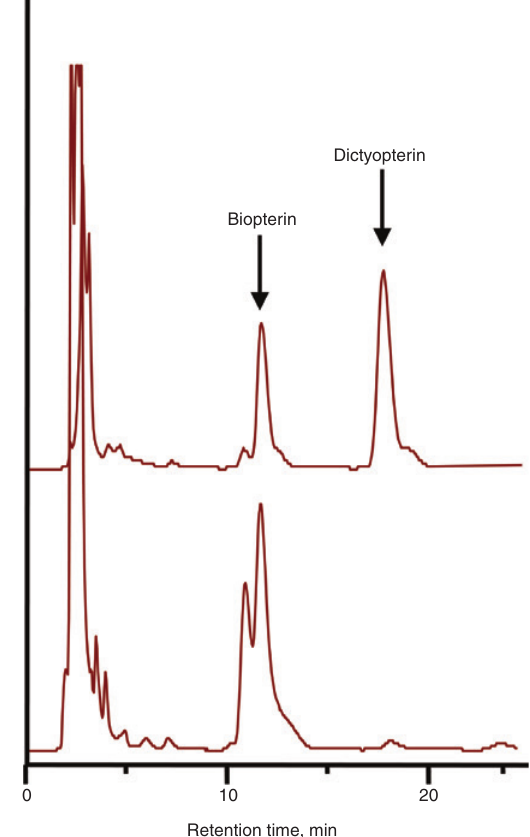
Figure 1: HPLC analysis of AR-like protein and AlrA activities in the crude extract of spr −